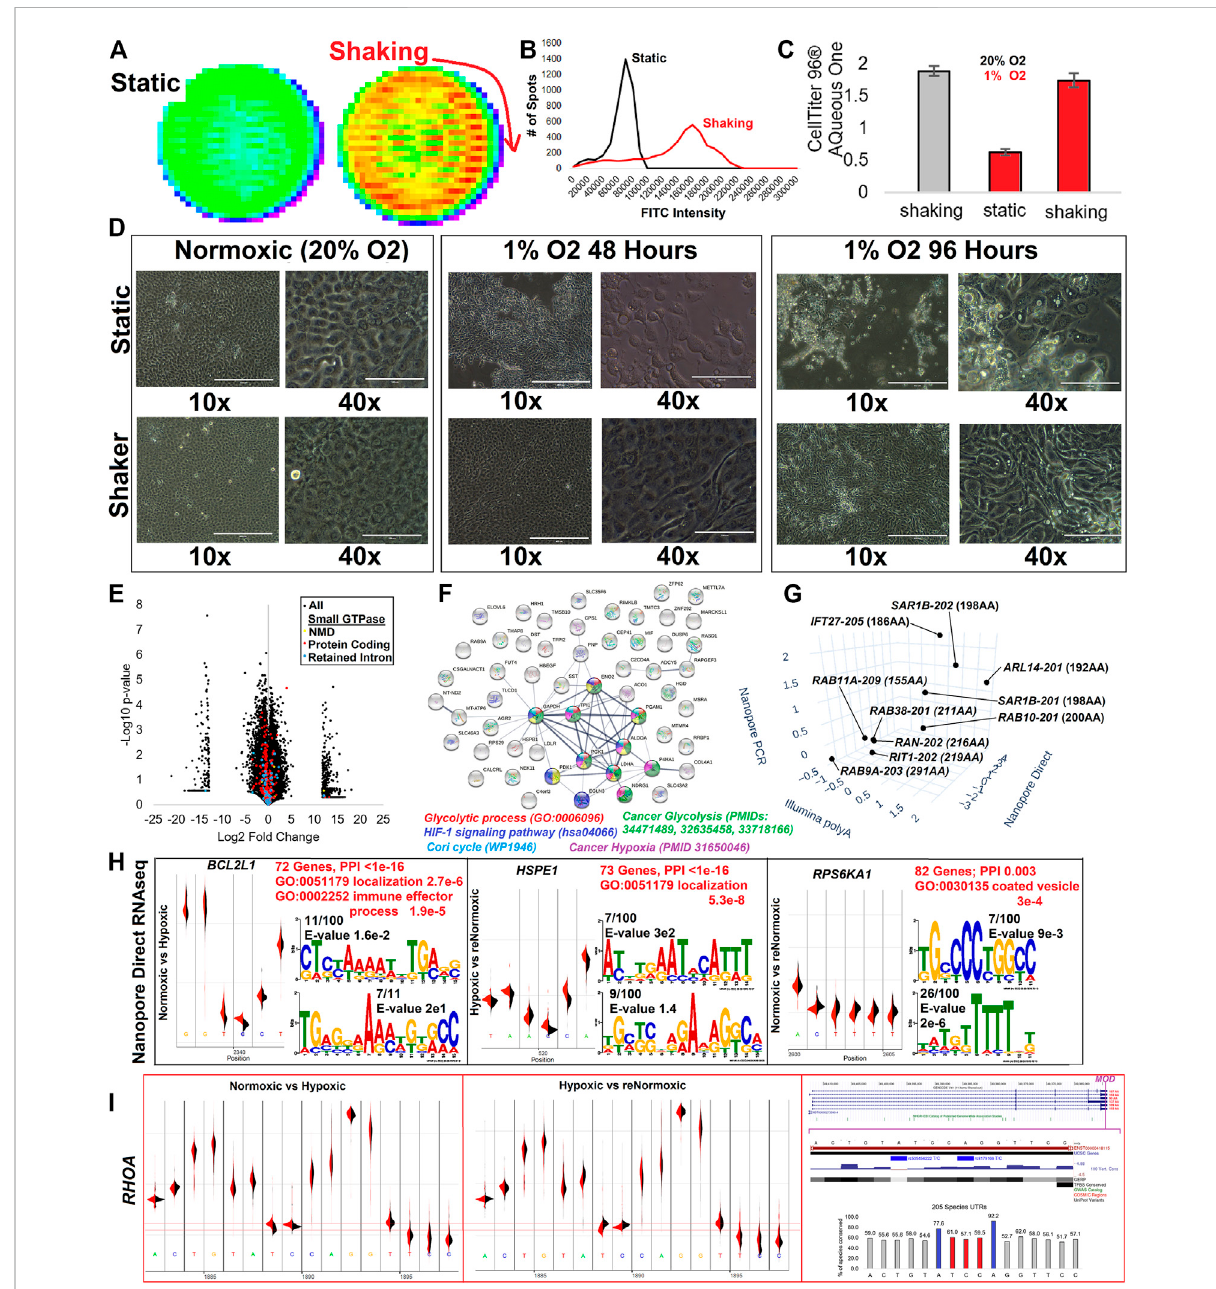
FIGURE 15 RNA modi fi cations to the multiple isoform UTR of RHOA. (A) Representative FITC-Albumin uptake assay in a well of a 6-well plate for cell static orundershakingbasedonsheerstressforRenalProximalTubuleEpithelialCellsimmortalizedwithTERT1(RPTEC-TERT1). (B) Analysisof (A) withthe number of spots measured for various FITC intensities. (C) The number of cells attached to the surface as determined by CellTiter 96 AQueous One measurement for cells under normoxia (20% O 2 ) and shaking (gray) or in hypoxia (1% O 2 for 48 h, red) either static or shaking. Error bars represent the standard error of the mean for 96 samples of each condition. (D) Light microscopy for cells at 10X or 40X under static or shaker conditions atnormoxia(20% O 2 ),1%O 2 for48 h,or1%O 2 for96 h. (E) VolcanoplotofIllumina polyA RNAseqfor normoxicvs. hypoxicRPTECunder sheer stress. Only isoforms with an average of 1 transcript per million (TPM) are shown. Small GTPase isoforms are colored for lncRNA (cyan), nonsense-mediated decay (yellow), protein-coding (red), and retained intron (blue). (F) STRING plot of genes having an isoform altered in Illumina polyA, Nanopore direct, and Nanopore PCR. Colors correspond to labels shown below for signi fi cantly enriched ontology terms. (G) Small GTPase isoformsshowingalteredexpressioninallthreedatasets.Eachaxisshowsthelog2foldchangeofnormoxicvs.hypoxiccellsfromthethreedatasets. (H) Differential analysis of base pair voltage for normoxic cells vs. hypoxic (left), hypoxic to renormoxic (middle), or normoxic to renormoxic (right). For each panel, the top mapped modi fi cation location is shown with density maps of the two groups (black vs. red). This is followed by red text indicating the number of genes with signi fi cant modi fi cations mapped, enrichment of protein-protein interactions (PPI) based on STRING analysis,